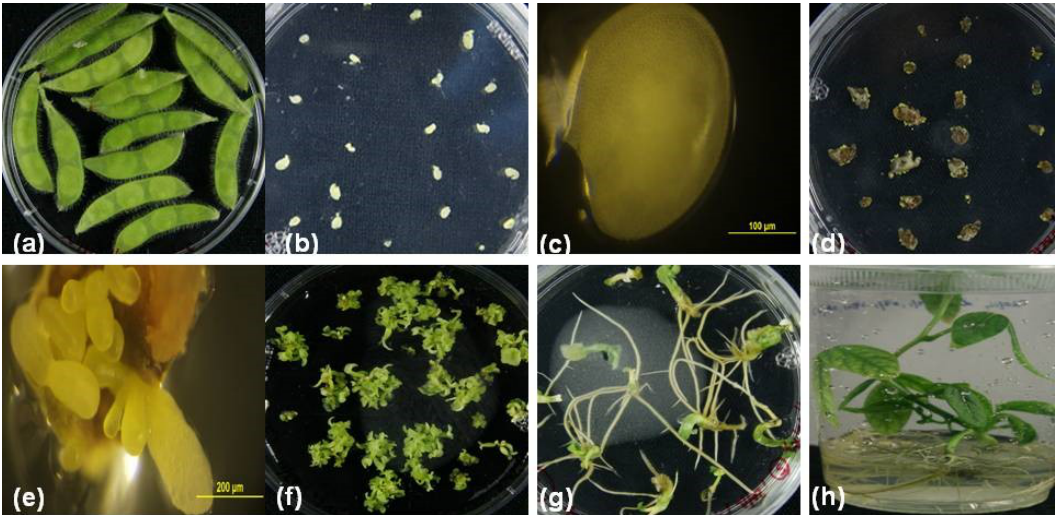
Figure 1. Steps in regenerating soybean plants through somatic embryogenesis (cv. Snowy is shown as an example), ( a ) immature pods for isolation of immature cotyledons; ( b ) immature cotyledons cultured on the D40 medium; ( c ) close view of the isolated immature cotyledons; ( d ) induction of somatic embryos after two months of culturing, ( e ) close view of somatic embryos, ( f ) proliferated histo-differentiated mature embryos, ( g ) germinated embryos, and ( h ) the rooted plants. Table 1. Summary of somatic embryogenesis response and regenerated soybean plants. Values with different lowercase letters are significantly different at p < 0.05.